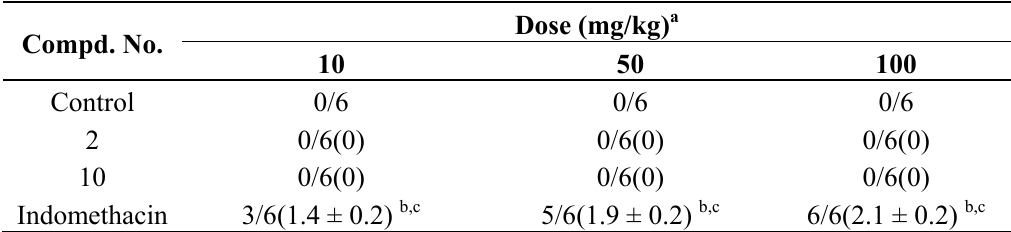
Table 2. Ulcerogenic activities of compounds 2 and 10 (Gastric Ulceration in mice a ). Compd.